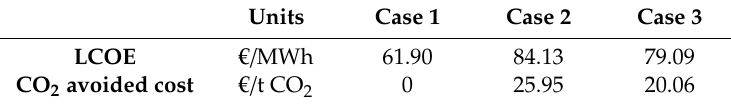
Table 6. Levelized cost of electricity and avoided CO 2 costs.